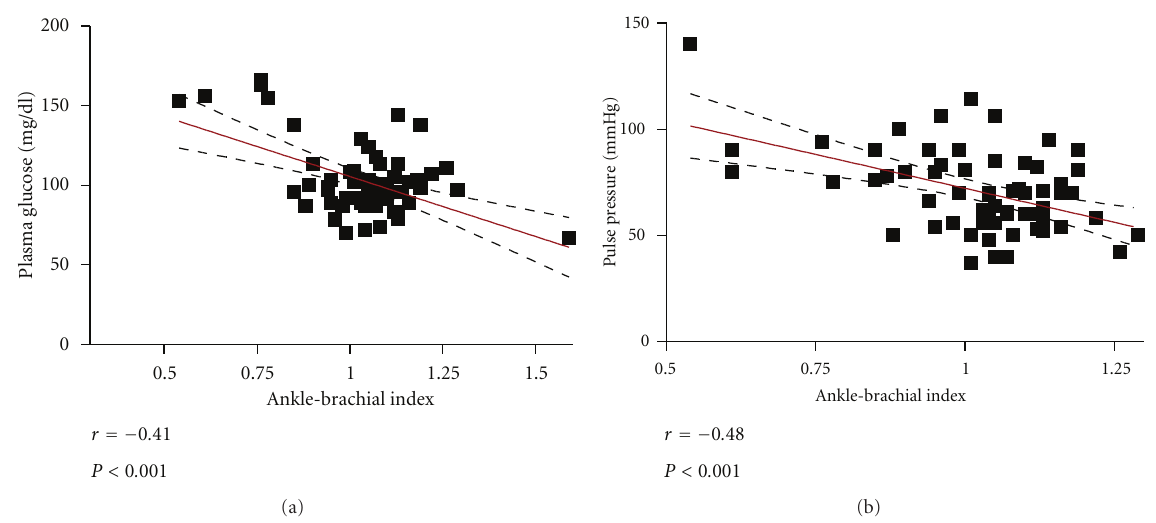
Figure 1: Correlation of ankle-brachial index (ABI) with fasting glucose (a) and with pulse pressure (b).